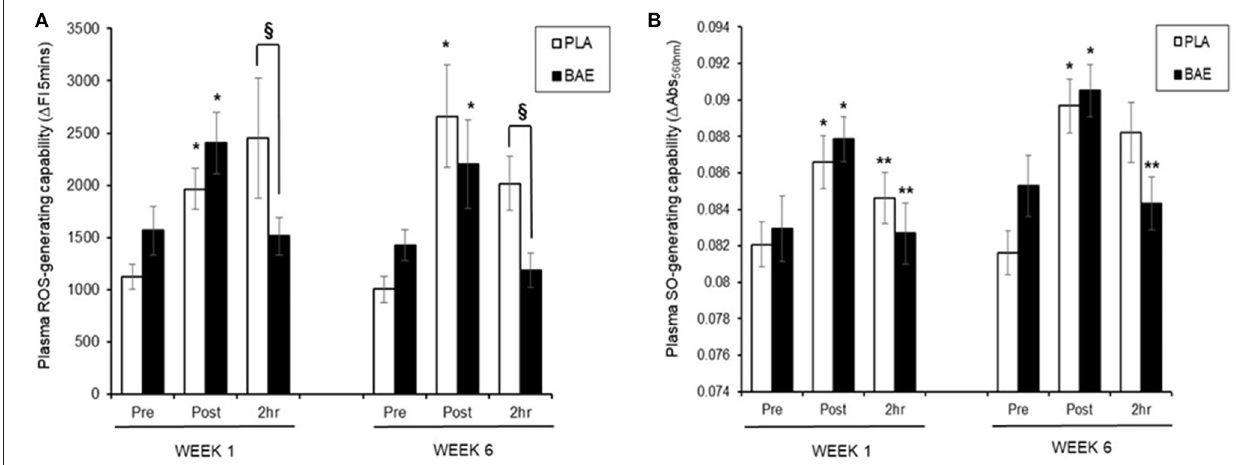
FIGURE 3 | The impact of blackcurrant anthocyanin-rich extract (BAE) or placebo (PLA) consumption 1h prior to exercise on plasma (A) reactive oxygen species (ROS)- and (B) superoxide anion (SO)-generating capability on week 1 and 6 after 5 weeks of daily consumption. Results are expressed as mean ± SEM, n = 18 individuals per group. * p < 0.05 represents statistical significance from corresponding pre-exercise values. ** p < 0.05 represents statistical difference from corresponding post-exercise values. § p < 0.05 represents statistical difference from PLA and BAE values.